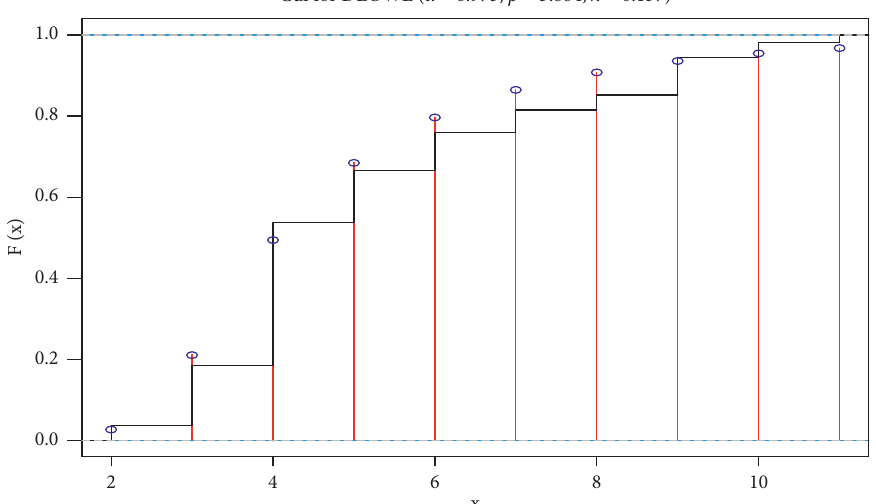
Figure 6: Graphical plots of the data and the CDF, as we can see in the plot, is distribution with the random variable with value x , where x is the number of deaths per